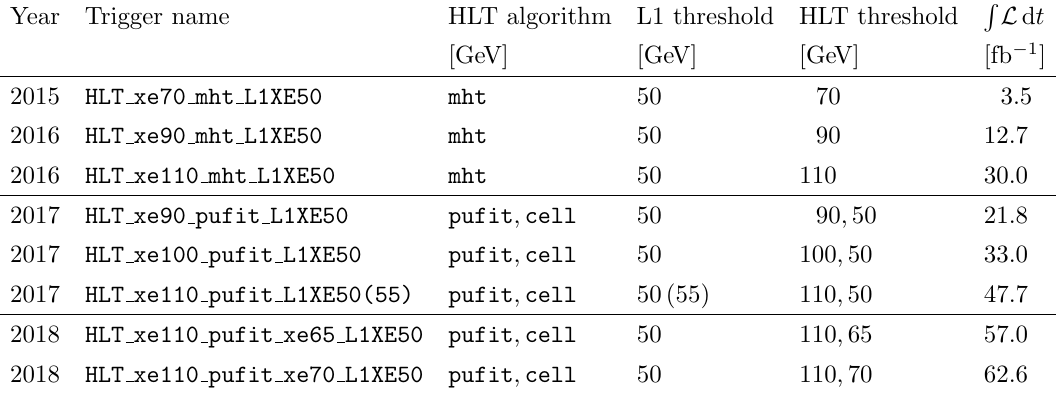
Table 2. The evolution of the primary E miss